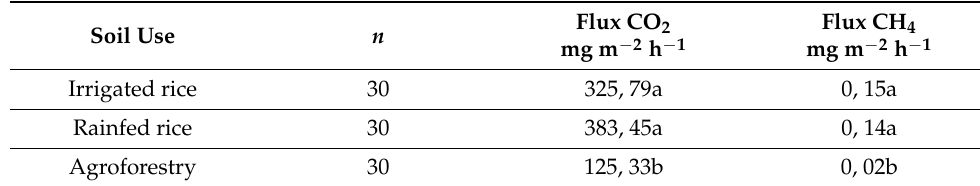
Table 4. Non-parametric comparisons of medians (Kruskal–Wallis) for CO 2 and CH 4 emissions by type of soil use.